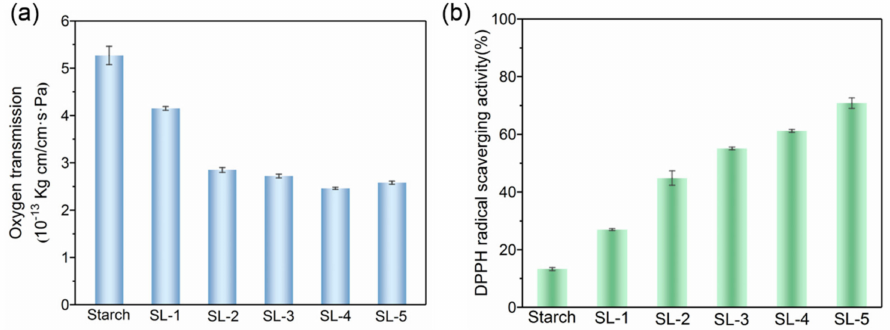
Figure 8. ( a ) Oxygen permeability and ( b ) DPPH radical scavenging rate of starch film and SL composite films containing 1% to 5%